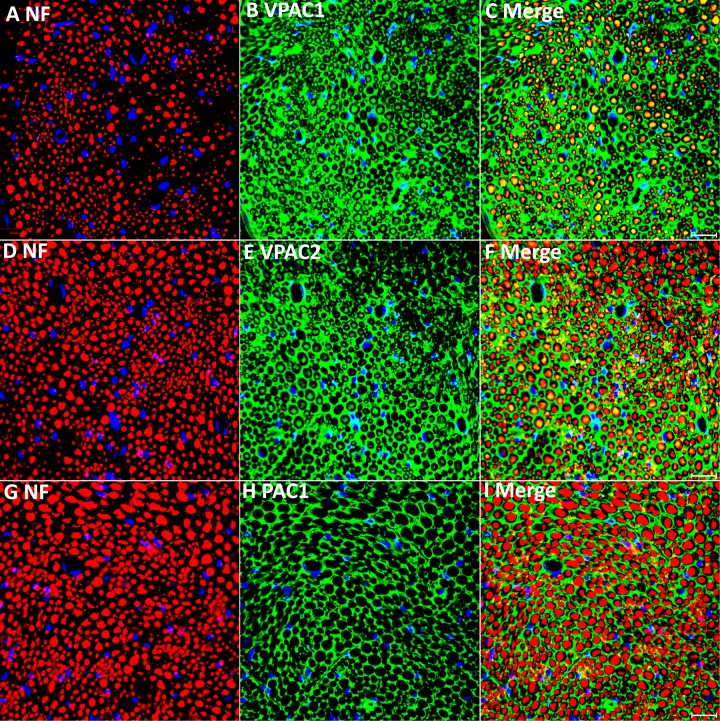
Double staining of VPAC1, VPAC2, and PAC1 with neurofilament heavy chain (NF) on transverse sections from intact mouse sciatic nerve. VPAC1 (A–C) and VPAC2 (D–F) staining both show co-localization with neurofilament (NF) but PAC1 (G–I) does not. Yellow color in (C,F) shows VPAC1 and VPAC2 co-localize with NF, respectively. VPAC1, VPAC2, and PAC1 also show positive staining in areas surrounding axons. Scale bars in (C,F,I) 20 μm. Three mice were used and three sections from each mouse were stained for each receptor.